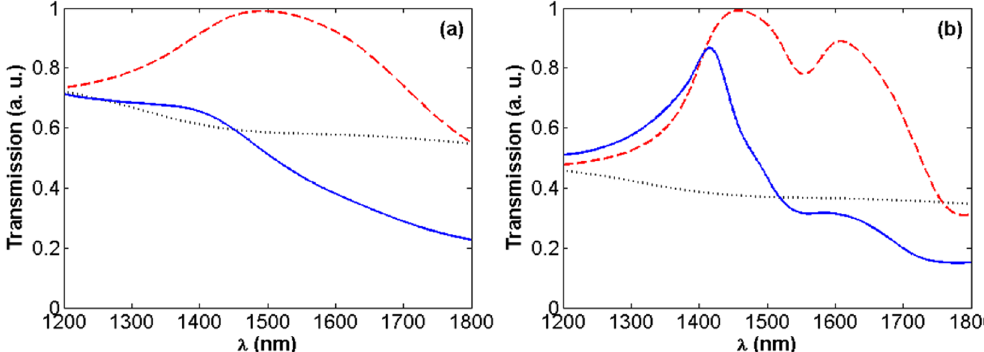
Figure 6. Transmission of light through the bare aperture (black-dotted), ENZ / A system (dashed-red), and ENZ / A / ENZ hybrid structure (solid-blue) considering lossy [panel (a)] and low-loss ITO [panel (b)] in the calculations, for Δ = 0. Δ is the dielectric spacer layer separating the aperture and the ENZ layers. Notice that the results are normalized to the maximum value (resonance peak) of the dashed-red curves.